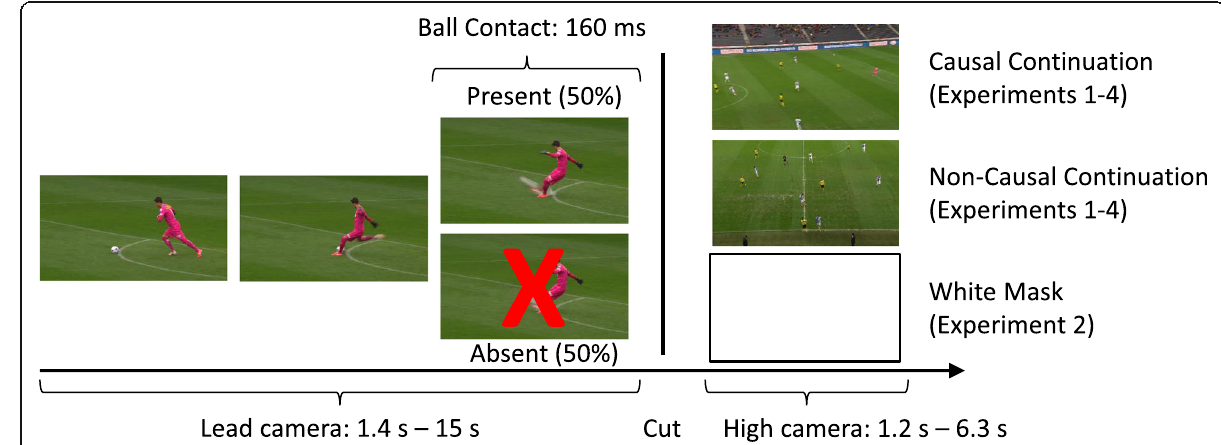
Fig. 1 Illustration of the timing and stimulus variations used in our experiments. Participants ’ task was to detect whether the critical moment of ball contact was either absent or present for each trial. We manipulated the continuation of the video clip after the cut. There was either a causal continuation, such as a ball flying across the field, a non-causal continuation, such as players preparing for a throw-in, or a white mask that covered the video content after the